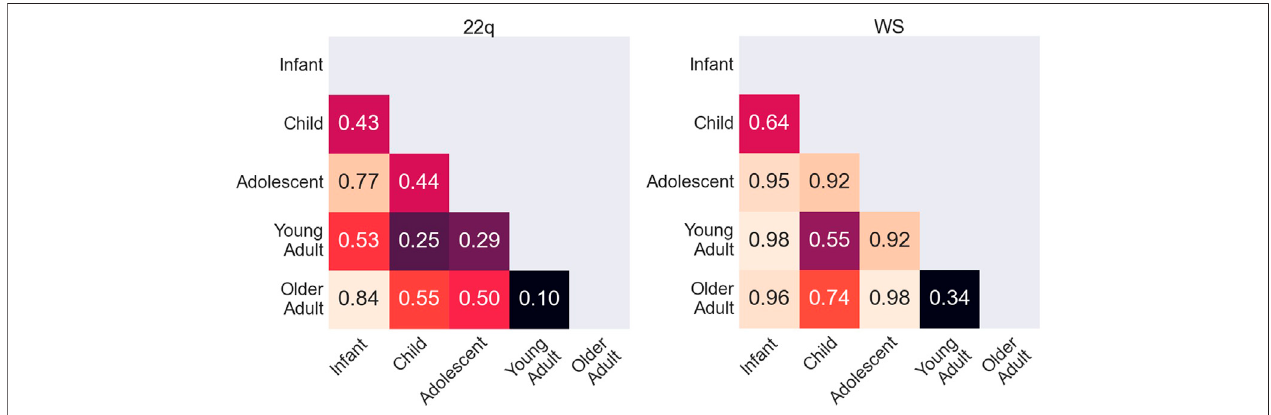
FIGURE 5 | Quantitative comparison of key facial features during aging. Rank of the observed Euclidean distance (in fraction out of 100 permutations) between embeddingsoftheaverages ofocclusion analysisfortwoage groups.Asmallnumberindicatesthatkeyfeatures identi fi edbytheneuralnetworkfortwoage groupsare more statistically similar, whereas alargernumber indicates that keyfeaturesare more statistically different. Possiblekey facial featuredifferencesacross age categories are qualitatively explained in Figure 4 .